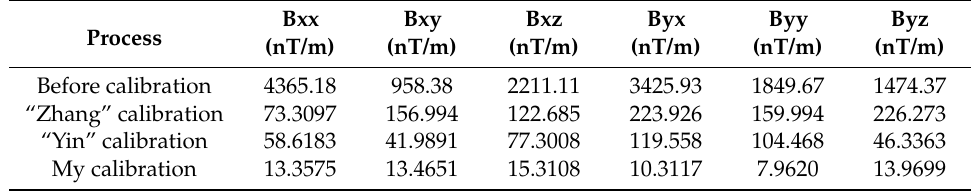
Figure 10. Comparison of tensor components before and after calibration in the experiment.